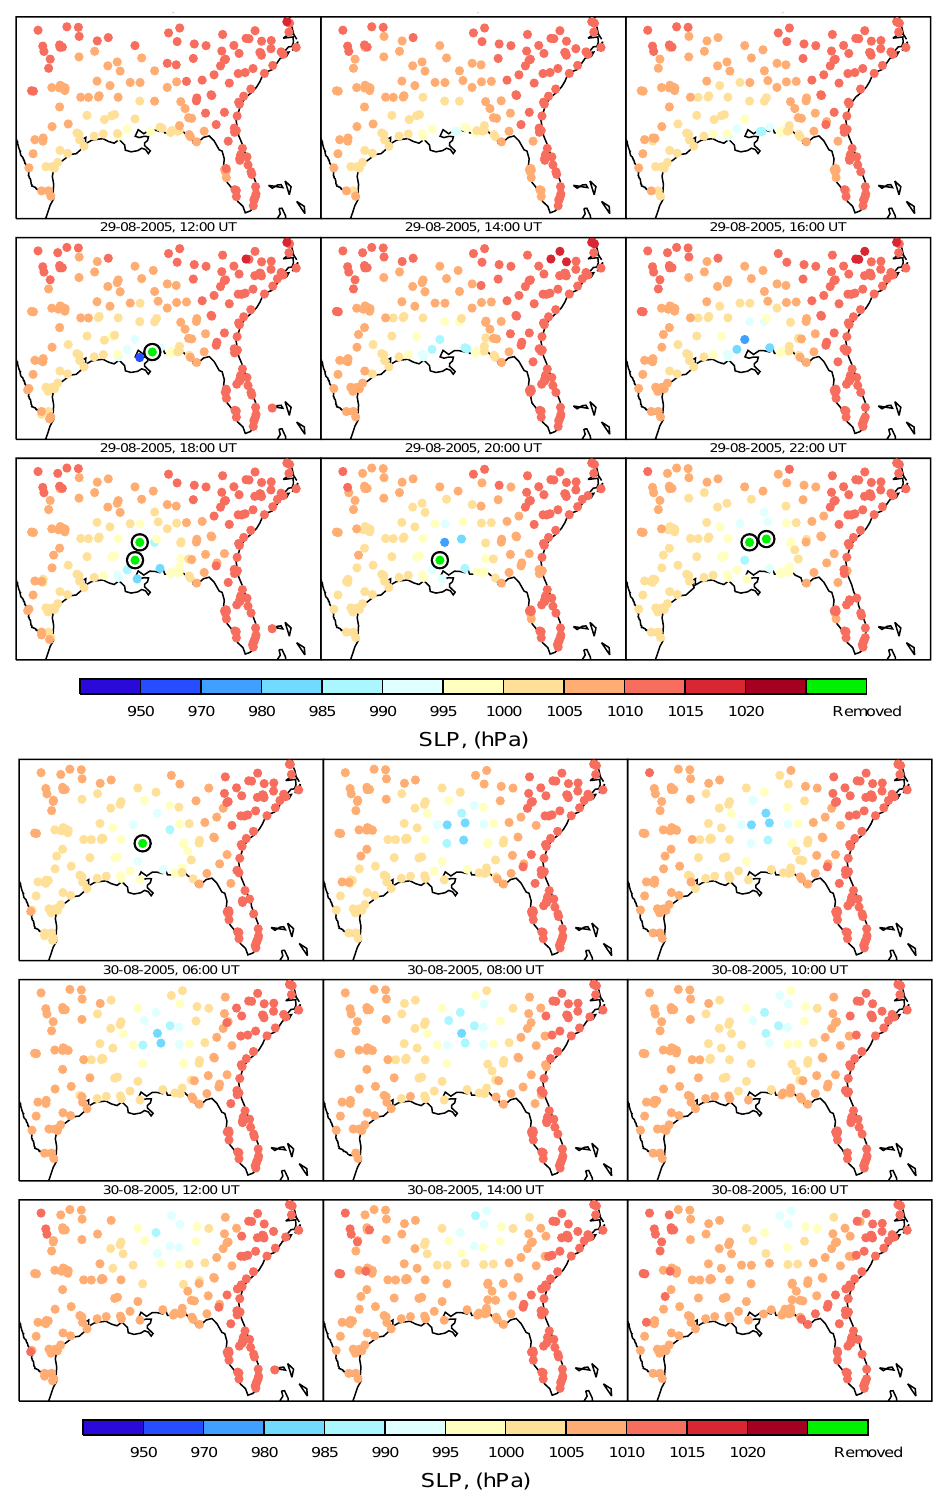
Fig. 17. Passage of low pressure core of Hurricane Katrina during its landfall in 2005. Every second hour is shown. Green points are observations which have been removed, in this case by the neighbour outlier check (see test